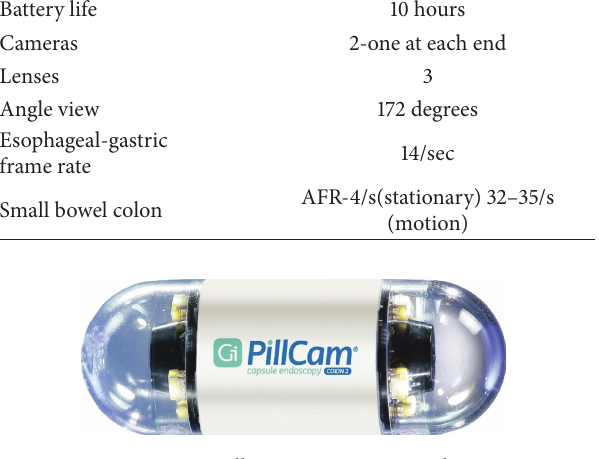
Figure 1: PillCam 2 COLON